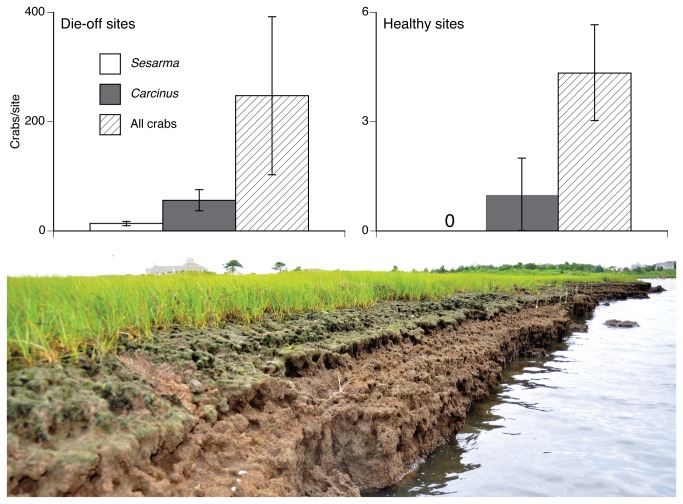
Abundance of intertidal Sesarma and Carcinus in creek banks at healthy and die-off sites.Note the order of magnitude difference in crab densities between site types. Carcinus outnumbered Sesarma at both sites, but were only common at sites with high Sesarma densities and consequently many burrow complexes and expansive die-off (bottom). Carcinus and Sesarma were never found in the same burrow and no evidence of predation was ever observed, suggesting Sesarma may exhibit a strong avoidance response to the presence of Carcinus.